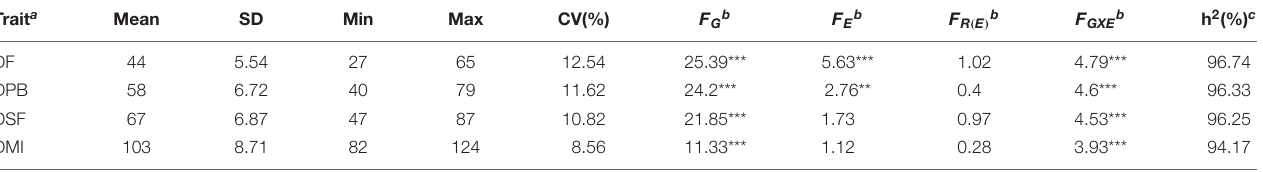
TABLE 1 | Descriptive statistics for four growth stage traits across six different environments in the 309 soybean accessions. Trait a